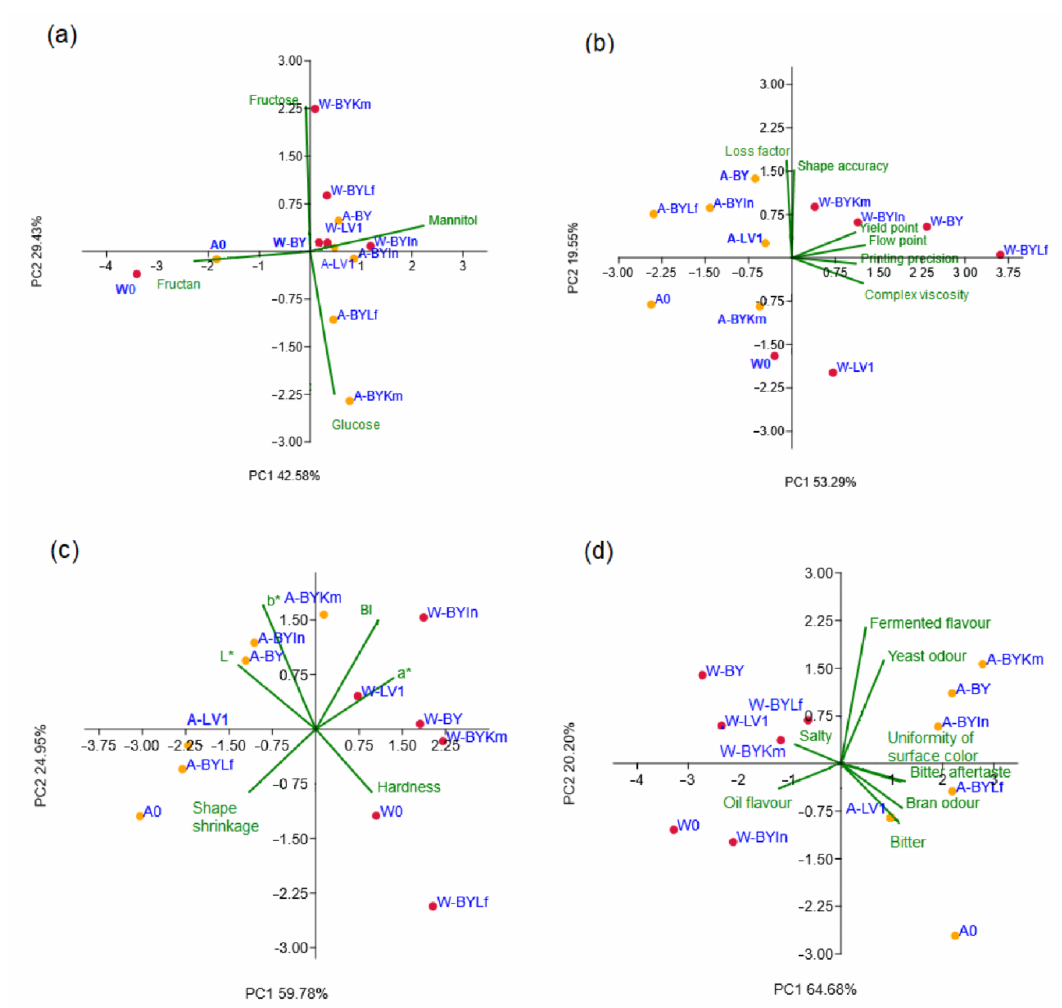
Figure 4. PCA bi-plots of investigated parameters: FODMAPs content ( a ), dough parameters ( b ), physical properties of snacks ( c ), and sensory attributes of snacks ( d ). W, wheat bran; A, amaranth bran; 0, control sample with unfermented bran; BY, bakery yeast; Lf, Limosilactobacillus fermentum ; Km, Kluyveromyces marxianus ; In,